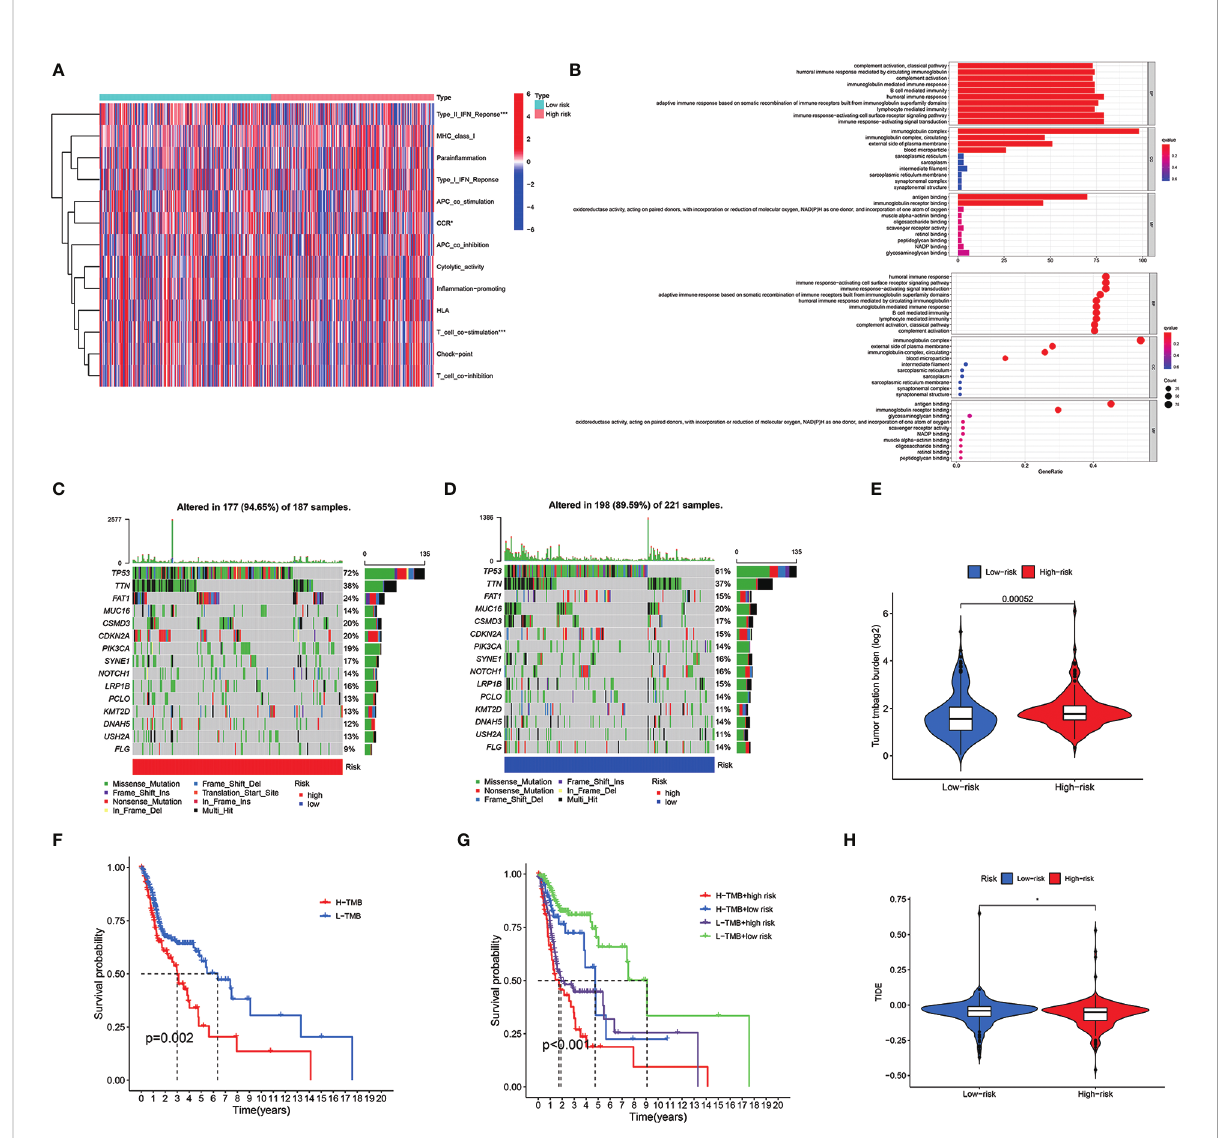
FIGURE 8 Tumor immune microenvironment and cancer immunotherapy response estimation by cuproptosis-related lncRNA model in TCGA entire set. (A) Every patient standard immunity index. (B) GO enrichment analysis. (C, D) Gene mutation information displayed in Waterfall plot and the high-risk group has higher mutation frequencies compared to the low-risk group. (E) TMB difference between the two risk groups. (F) OS Kaplan-Meier curve analysis displayed for patients who rely on TMB. (G) OS Kaplan-Meier curve analysis according to TMB and risk score (H) TIDE prediction differences in both groups. *means p < 0.05, ***means p <